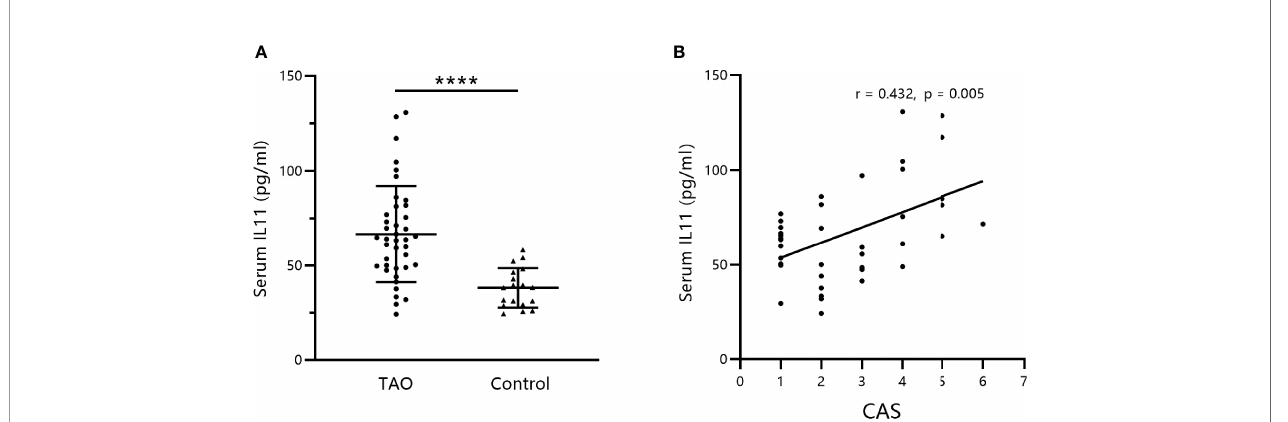
FIGURE 1 | Serum IL-11 levels are elevated in thyroid-associated ophthalmopathy (TAO) patients and correlated with disease activity. (A) IL-11 levels were analyzed by enzyme-linked immunosorbent assay in serum obtained from the venous blood of TAO patients and healthy subjects (TAO, n = 40; control, n = 18). The data are expressed as the mean ± standard deviation (SD). ****P < 0.0001. assessed by two-tailed student ’ s t-test. (B) Correlation between IL-11 levels in patients with TAO and the Clinical Activity Score (CAS). Spearman ’ s test was used for the correlation analysis. P < 0.05 was considered signi fi